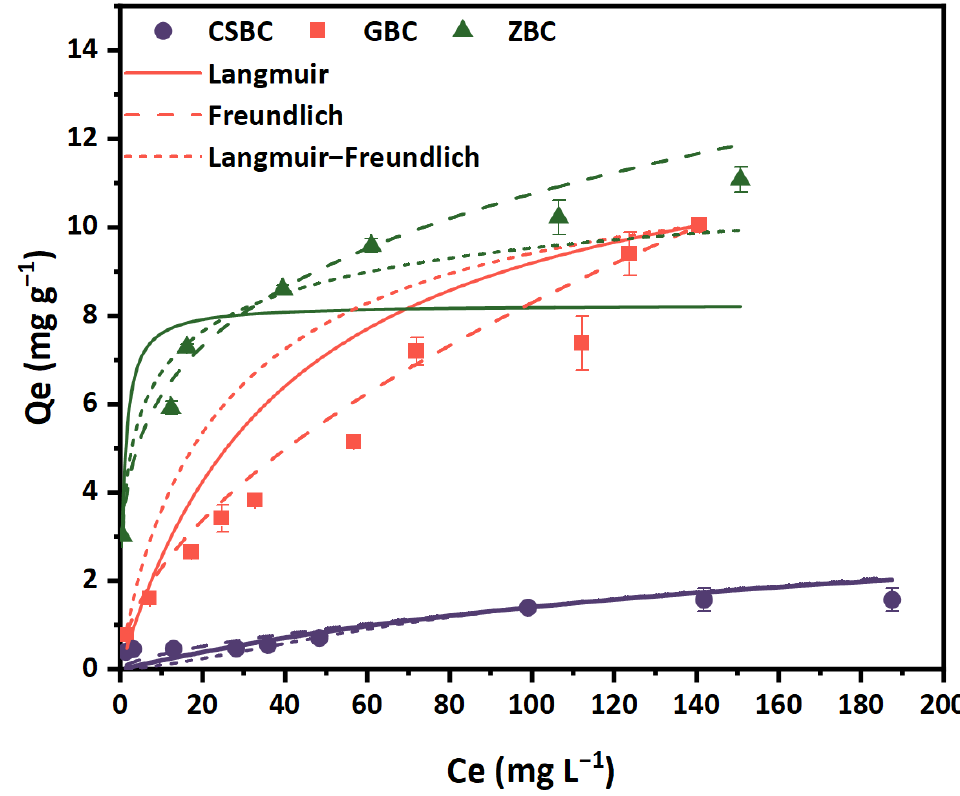
Figure 5. Adsorption isotherms of P by CSBC, GBC, and ZBC. (Adsorbent dose: 5 g L − 1 ; adsorption time: 4 h ( CSBC and GBC) and 8 h (ZBC); pH: 6; temperature: 25 °C; ionic strength: 0.01 M.) Table 3. Parameters for the adsorption isotherm for P removal by GBC, CSBC, and ZBC. Langmuir Freundlich Langmuir – Freundlich